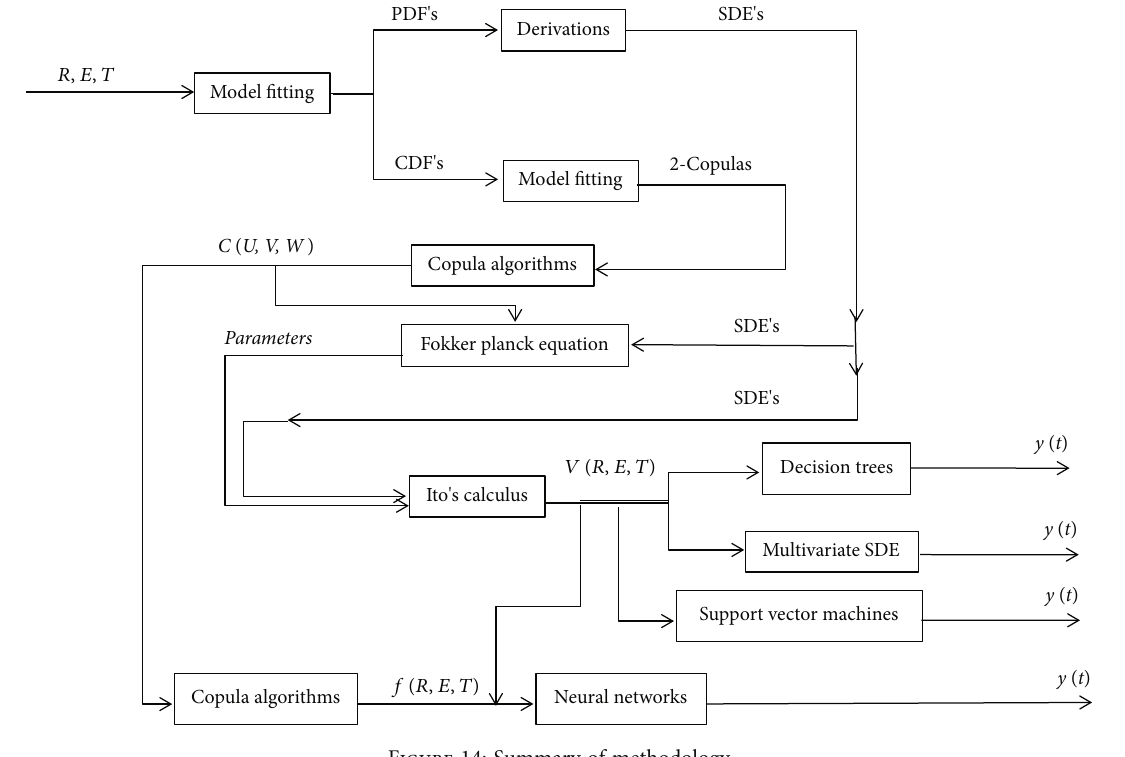
Figure 14: Summary of methodology Table 7: E ffi ciency of